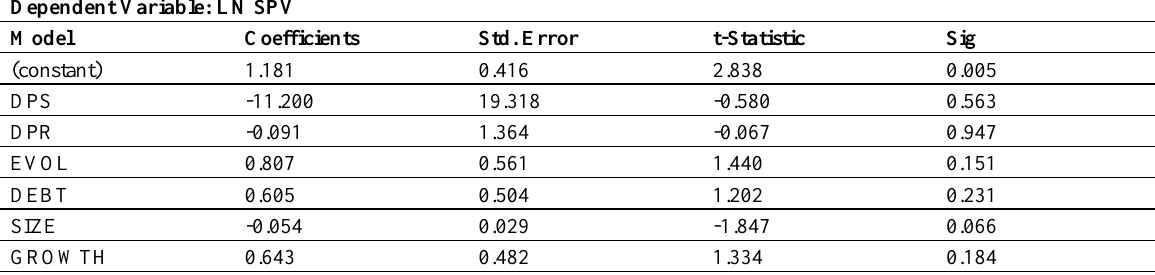
Table 6: Regression Result Test